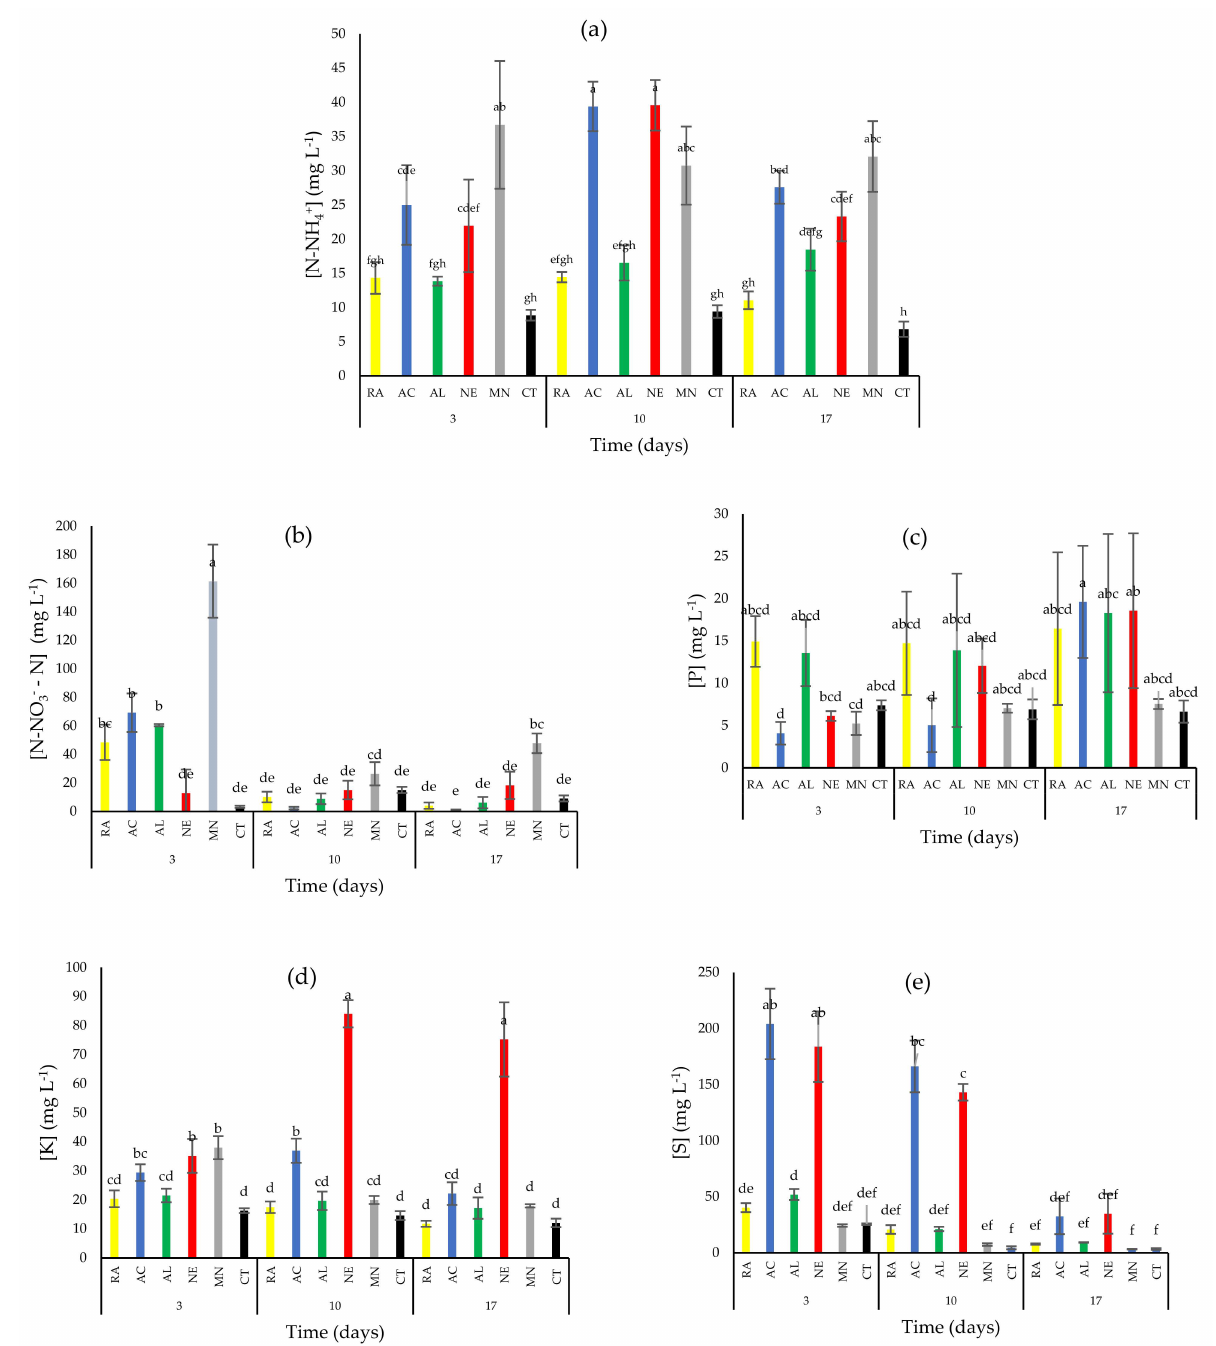
Figure 2. Effect of fertilizer treatment (RA = Raw dairy slurry; AC = Acidified dairy slurry; AL = Alkalinized dairy slurry; NE = Neutralized dairy slurry; MN = Mineral fertilizer; CT: Control) and time after fertilizer application (3, 10, and 17 days) on the [NH 4+ -N] (mg L − 1 ) ( a ), [NO 3 − -N] (mg L − 1 ) ( b ), [S] (mg L − 1 ) ( c ), [P] (mg L − 1 ) ( d ), and [K] (mg L − 1 ) ( e ) values in leachates. Two-way ANOVA indicated a positive interaction of both parameters. Mean values ( n = 4) with different letters indicate significant differences based on the Tukey test ( p < 0.05). Error bars represent standard errors of 4